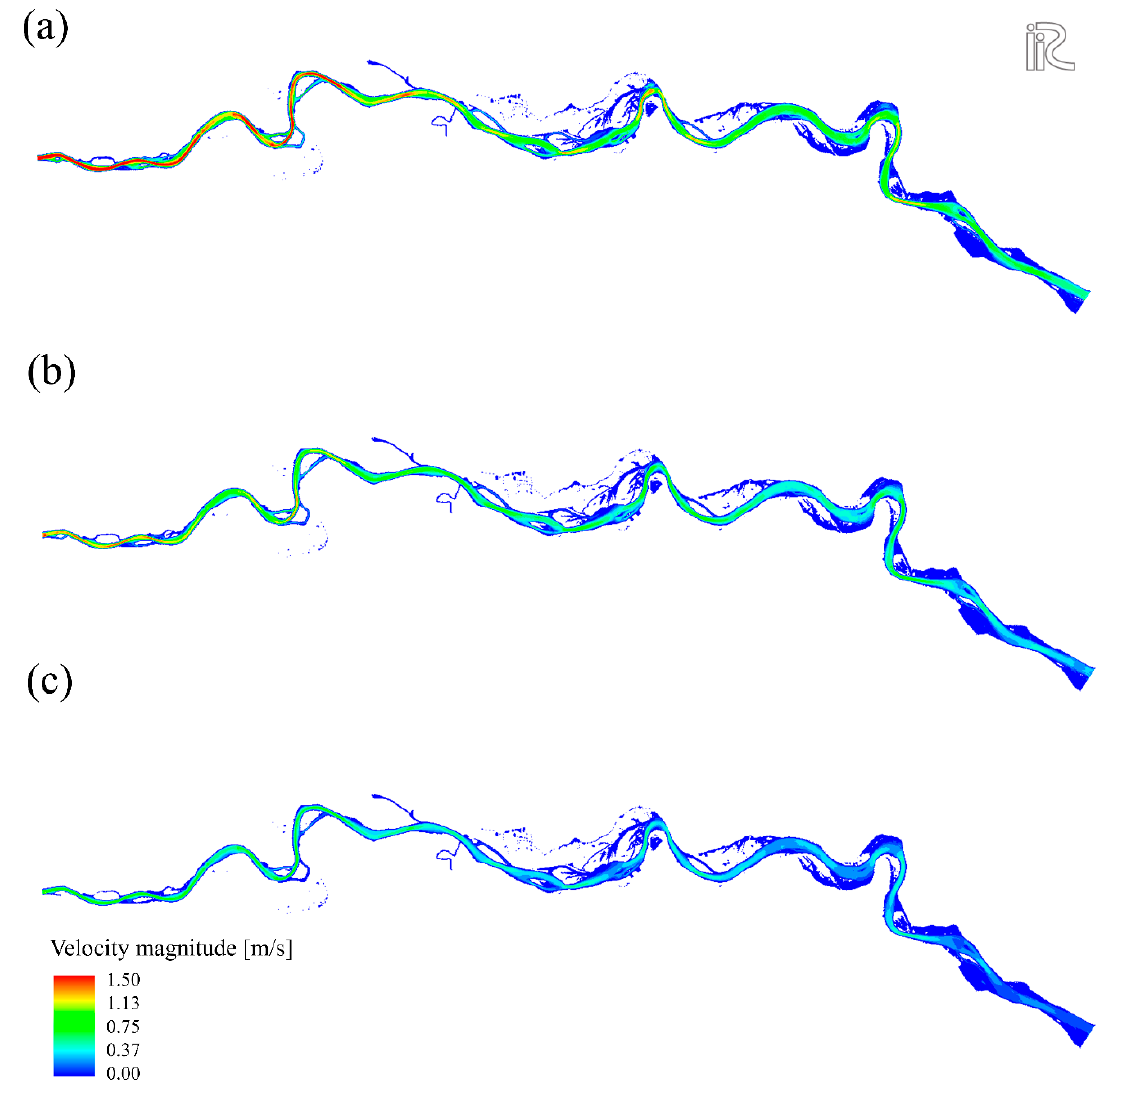
Figure 2. Simulated velocity profiles for the ( a ) maximum, ( b ) mean, and ( c ) minimum discharge.